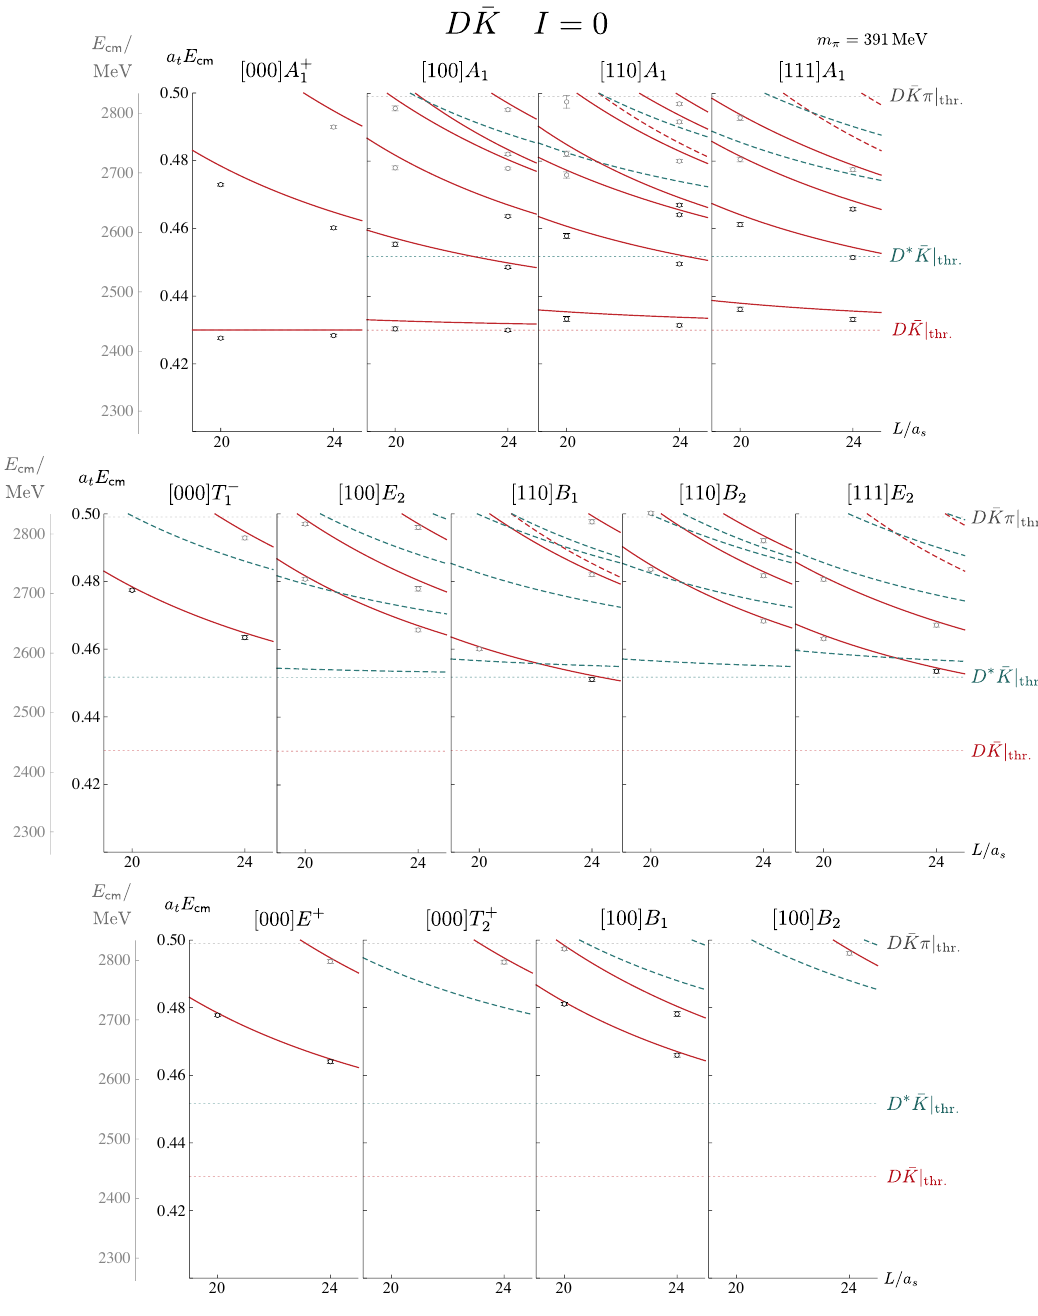
Figure 6 . As figure 3 but for I = 0 D ¯ K on the m π = 391 MeV